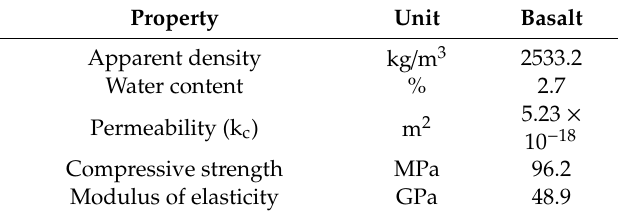
Table 2. Initial properties of tested concrete (mean values).